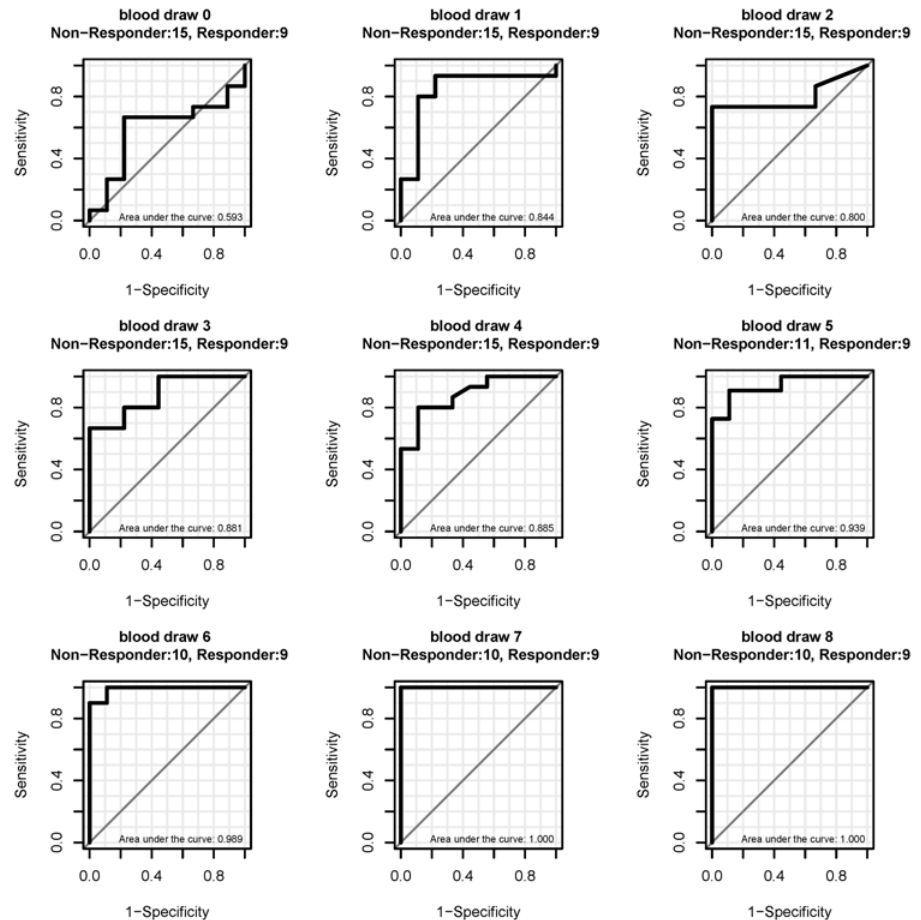
Fig 2. ROC curves for the discrimination of responders from non-responder at different blood draws. Only patients with a baseline PMR (cid:3) 1% were included. The first blood draw (time 0) is the point before treatment (= baseline methylation). Blood draws 1 to 8 were taken during the therapy at intervals of 7 to 10